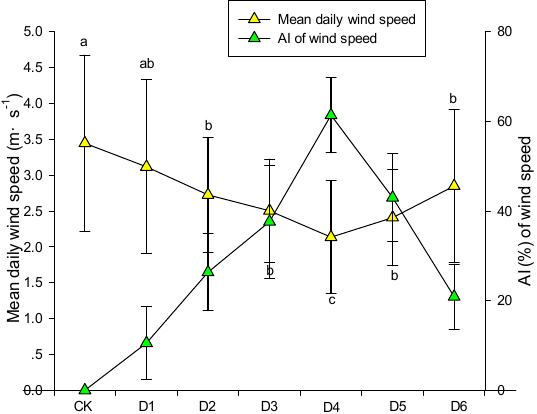
Figure 3. Variations in mean daily wind speed at 2-m height and the attenuation index (AI) of wind speed. Means with different letters indicate significant differences at p < 0.05. Vertical bars represent ± standard deviation.